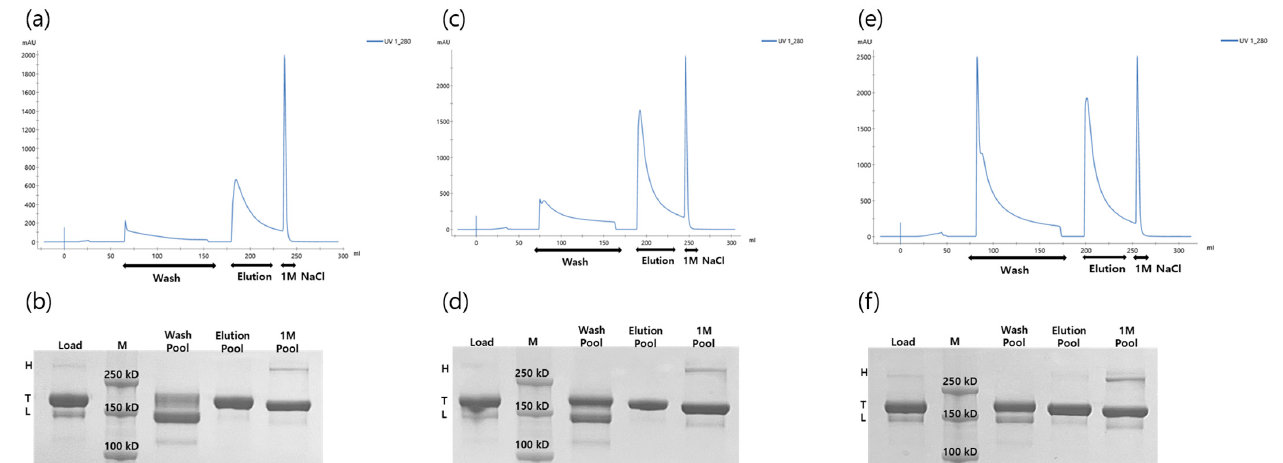
Figure 5. Impact of DBC on Fc-fusion protein using Fractogel ® EMD SO 3 − (M) resin. Band H: HMW proteins; band T: target protein; band L: LMW proteins. The wash step was performed at a conductivity of 50 mS/cm. and the elution step was performed at a conductivity of 60 mS/cm, respectively. ( a , b ) DBC condition: 10 g/L of resin, ( c , d ) DBC condition: 20 g/L of resin, ( e , f ) DBC condition: 30 g/L of resin.